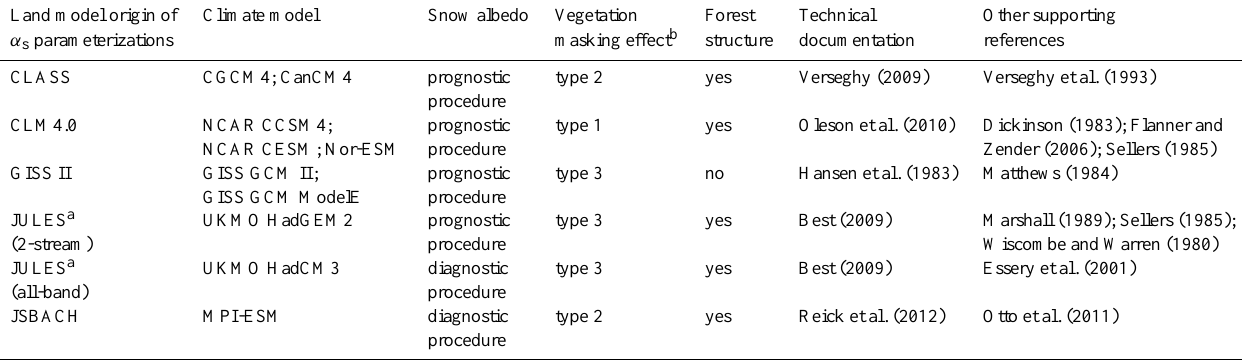
Table 2. Albedo parameterizations included in the analysis and their associated land and climate models. Land model origin